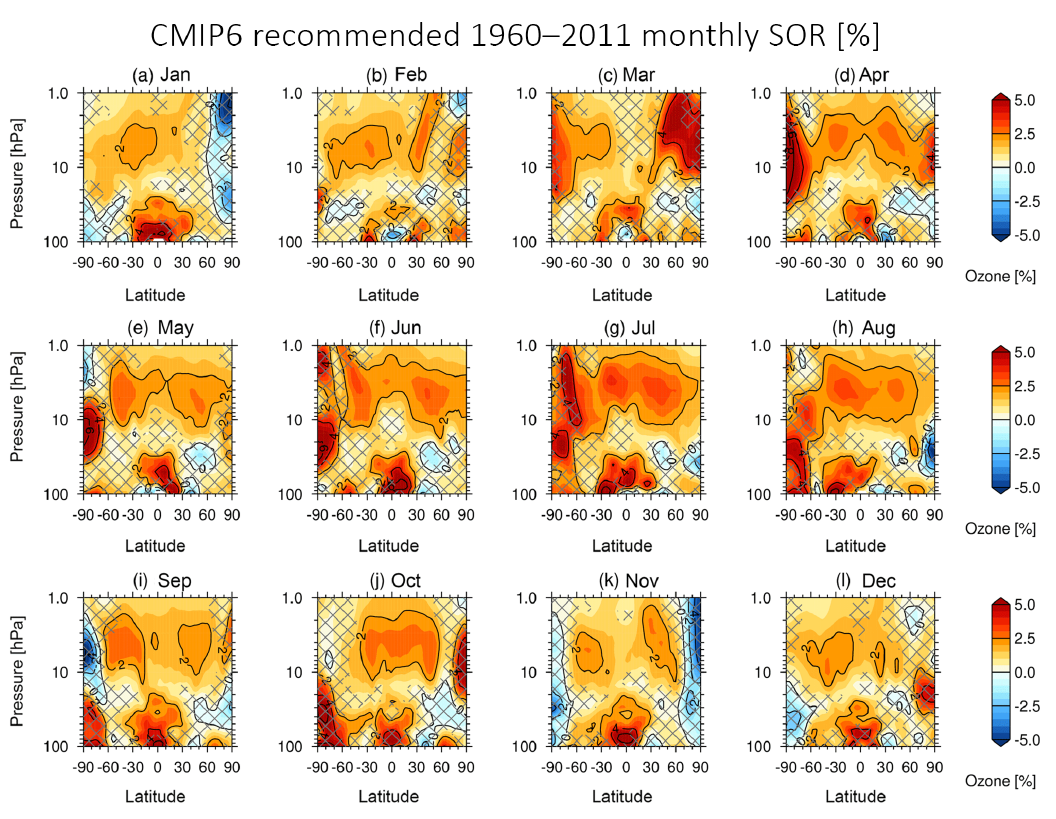
Figure 8. Monthly mean percent (%) ozone anomalies per 130SFU for (a) January to (l) December in the CMIP6 ozone database. The solid contours denote 2% intervals. Hatching denotes regions where the regression coefficients are not significantly different from zero at the 95% confidence